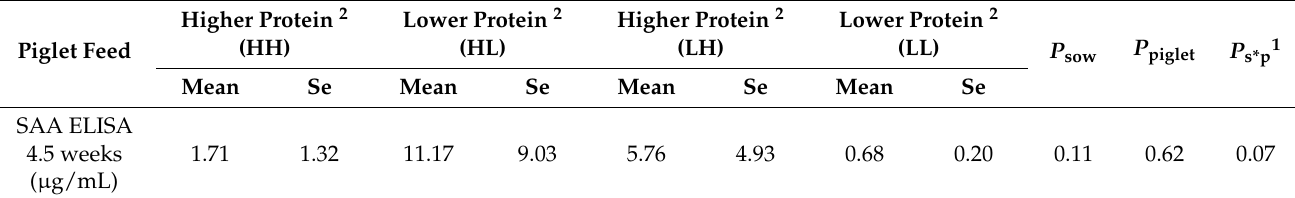
Table 4. Mean values for the SAA ELISA serum concentrations at 4.5 weeks of age of the piglets with both sow and piglet treatment at 4.5 weeks of